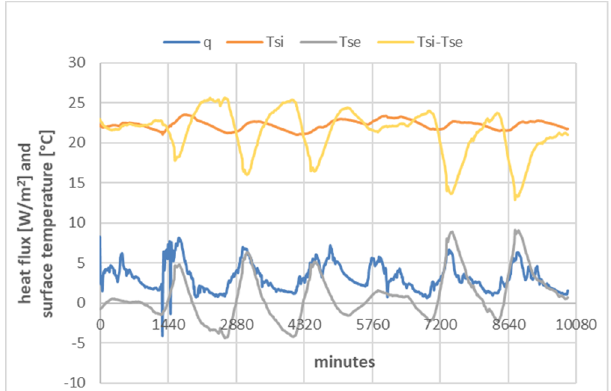
Figure 17. Casa Cembo: heat flux and surface temperatures from January 23 rd to 30 th 2019.